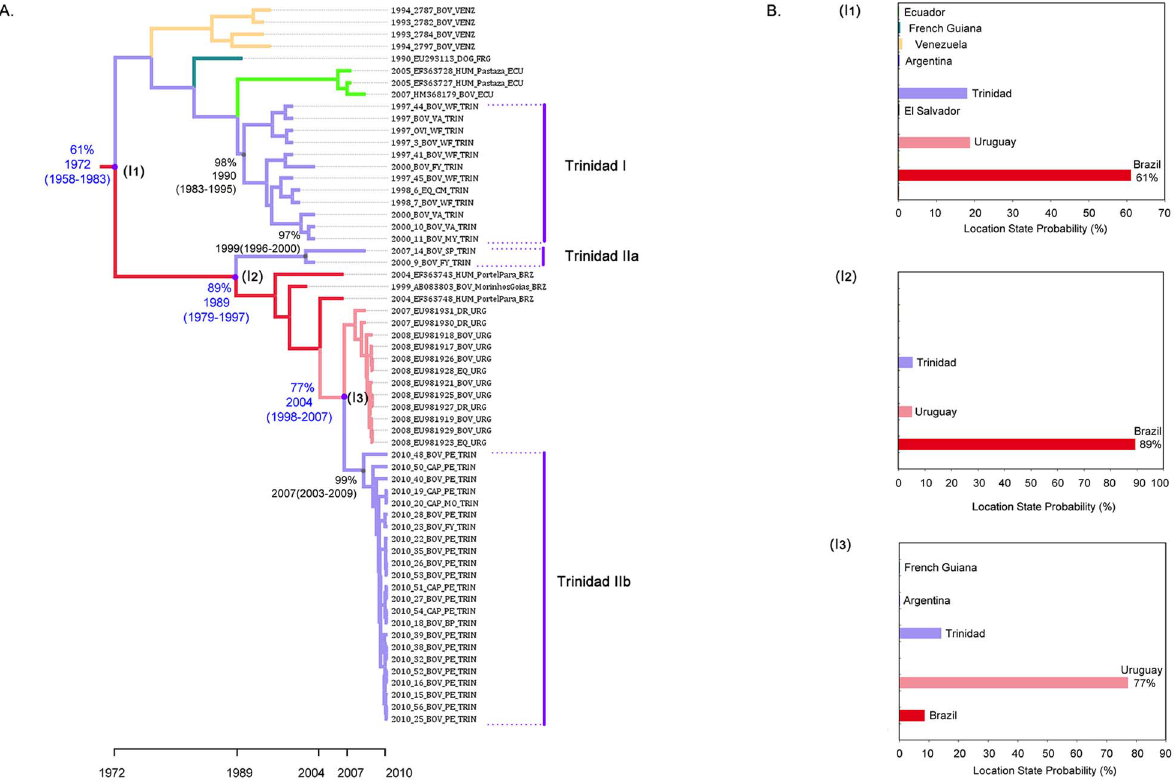
Figure 3. (A) Enlargement of the section of MCC tree containing Trinidadian lineages. The location state probabilities for selected nodes are shown as percentages. The estimated dates of divergence from mainland lineages and mean dates of existence for the most recent common ancestor (MRCA) for lineages containing Trinidadian sequences (with 95% HPD in parentheses) are shown in blue and black respectively to the left of relevant nodes. ( B ) Histogram inserts indicating the location state probabilities for the estimated introductions of RABV that gave rise to Trinidad lineages I (I1), IIa (I2) and IIb (I3).